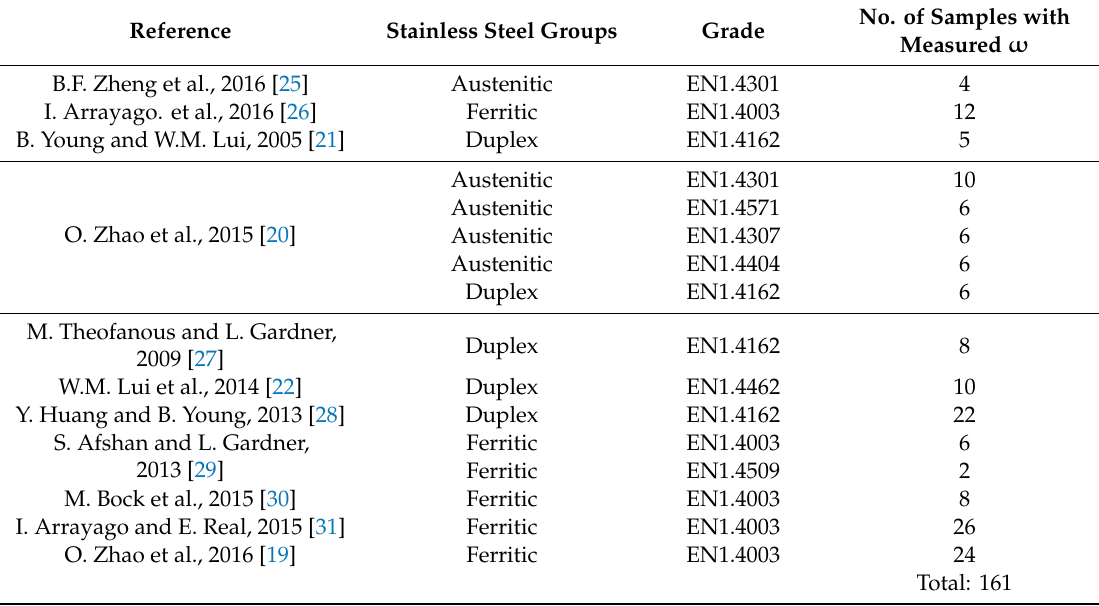
Table 1. Summary of the samples collected from the